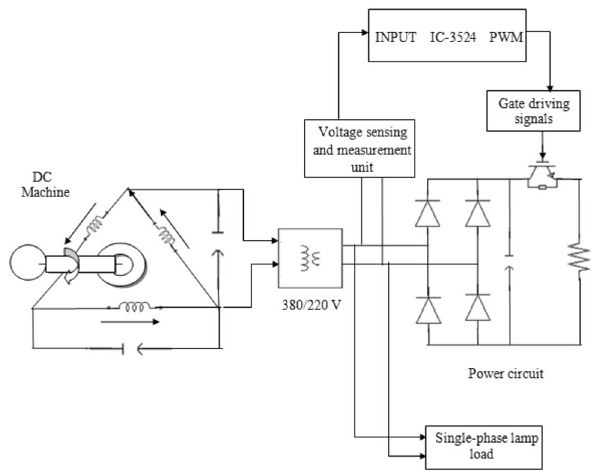
Fig.1 Schematic diagram of three-phase IAG feeding single-phase load along with